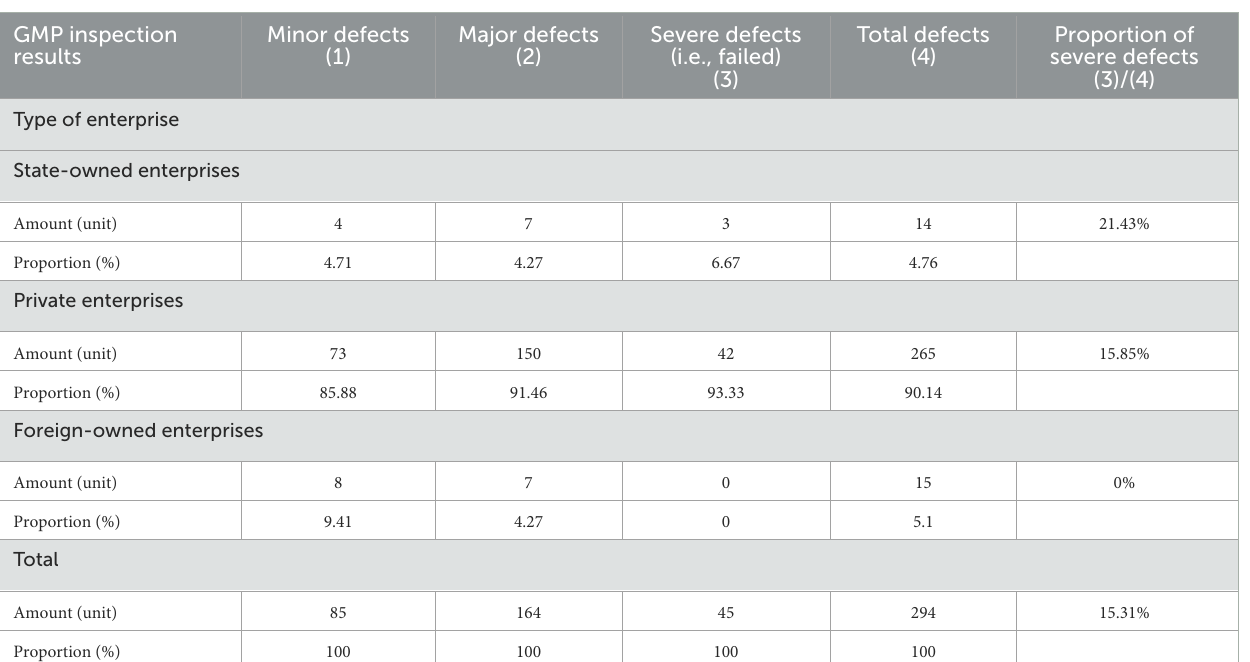
TABLE 1 Comparison of GMP inspection results of enterprises with different ownership types.